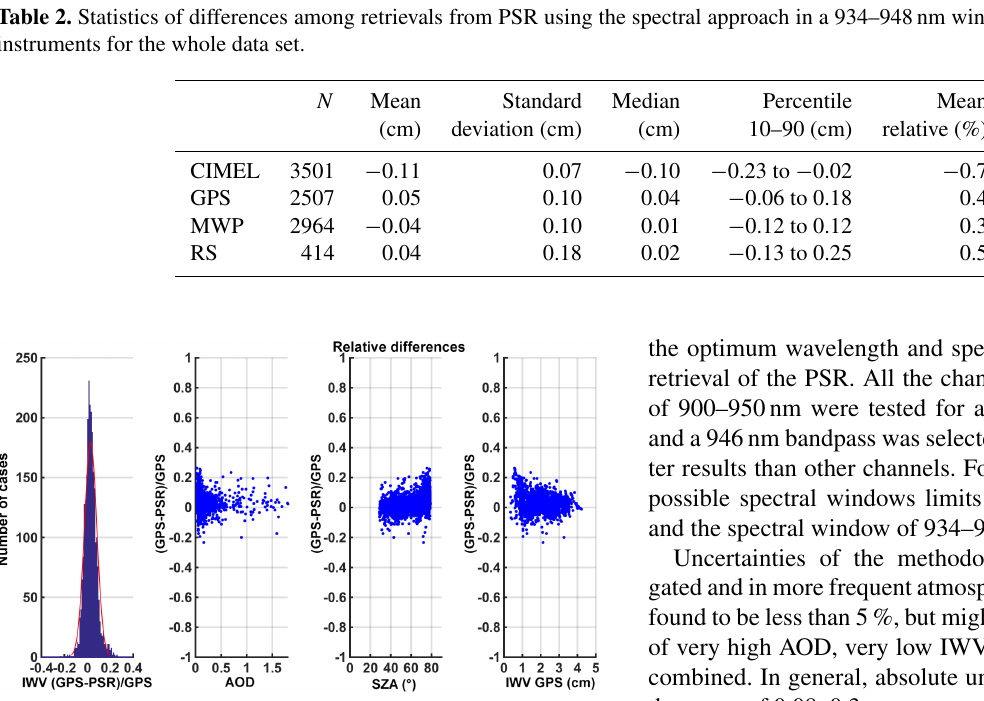
Figure 12. Relative difference among synchronous GPS and PSR retrievals – using a spectral approach at 934–948nm region – plot- ted against (a) AOD (retrieved from PSR at 865nm), (b) solar zenith angle and (c) IWV (retrieved from